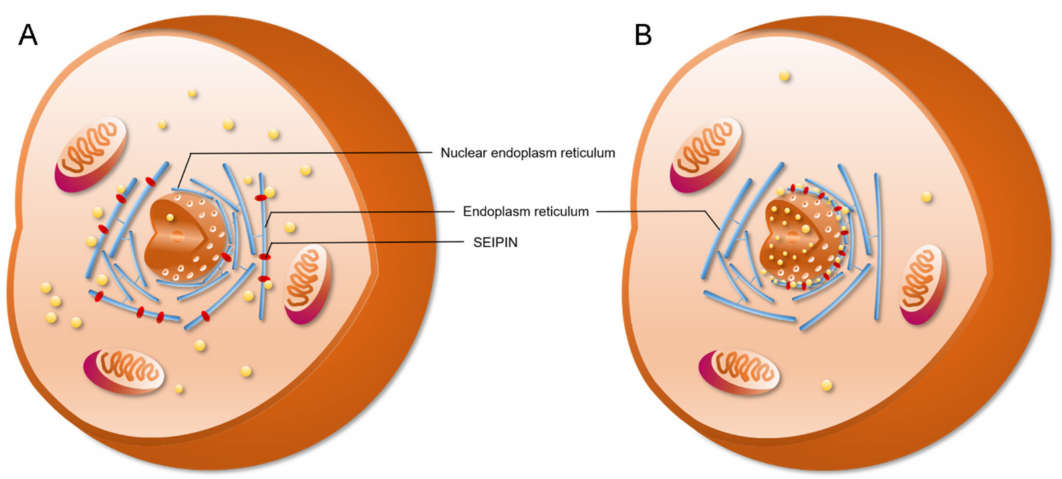
Figure 4. SEIPIN localization a ff ects nuclear lipid droplets generation. ( A ) SEIPIN is normally an endoplasm reticulum (ER)-localized protein. SEIPIN localized at the ER induces the generation of cLDs. ( B ) When expressing nuclear-ER-trapped SEIPIN in SEIPIN knockout cells, more nLDs were